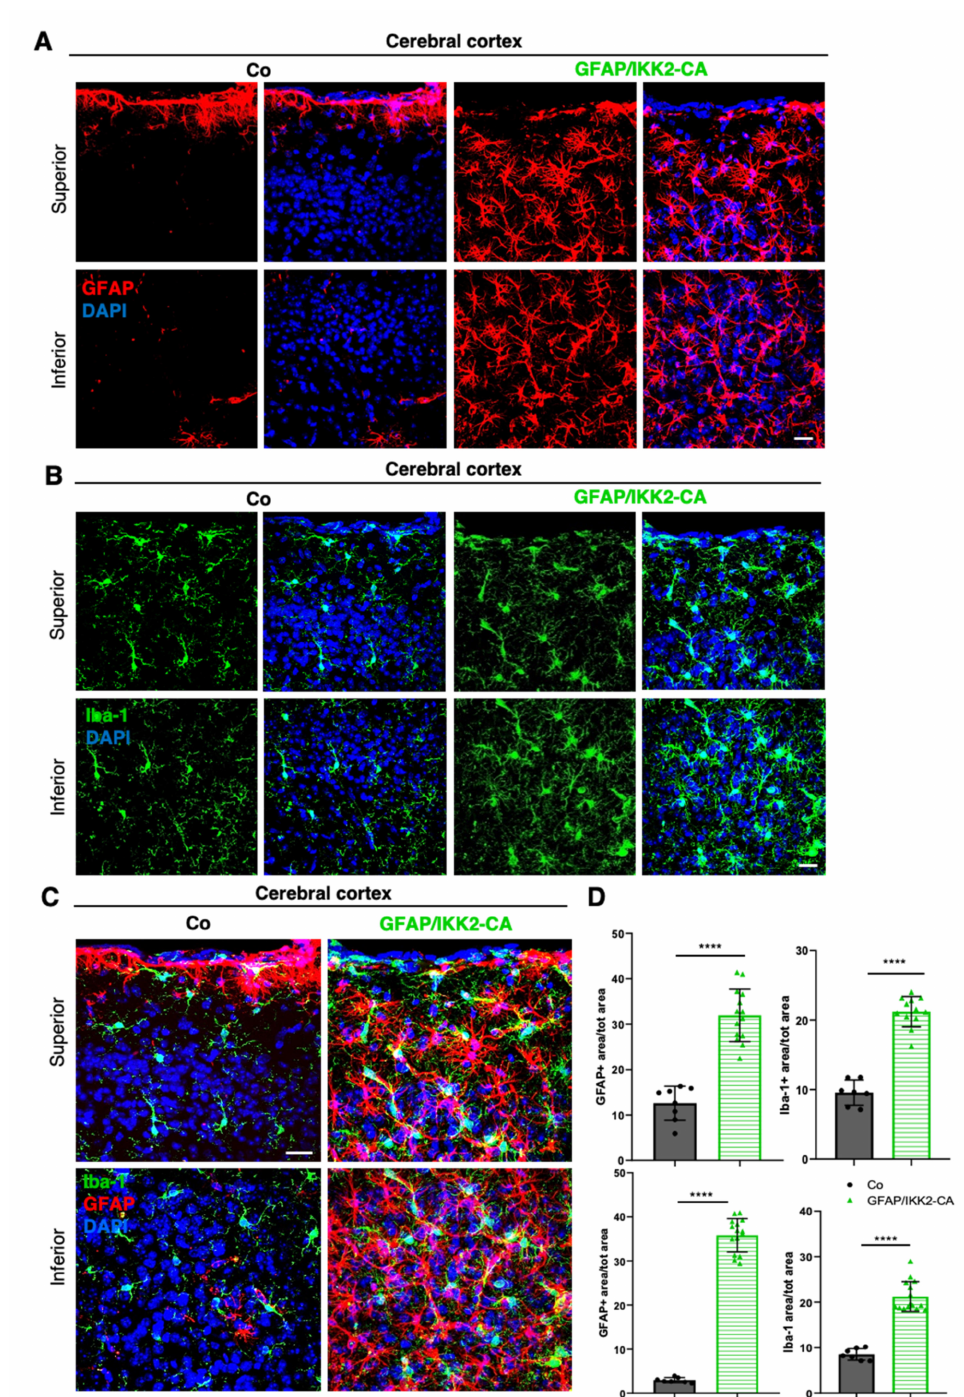
Figure 2. Selective activation of IKK2/NF- κ B signaling in astrocytes induces strong astrogliosis and microgliosis. Representative pictures showing IF staining of astrocytic marker GFAP ( A ) and microglial cells marker IBA-1 ( B ) in the superior and inferior cerebral cortex of control mice and GFAP/IKK-CA littermates. ( C ) High-magnified pictures depicting co-IF staining of GFAP and IBA-1 markers in the superior cerebral cortex. The panel displays interaction between the two types of glial cells and underlines the increase in number and area covered by astrocytic and microglial cells in GFAP/IKK2-CA mice in relation to Co littermates. Nuclei are labeled with DAPI (blue). ( D ) Quantitative analyses show a significant increase in GFAP+ astroglia ( A ) and IBA-1+ microglia area ( B ) in the GFAP/IKK2-CA mice compared to control mice. Cryo-sections thickness = 40 µ m; Scale bar = 20 µ m. Statistical analysis: ANOVA multiple comparison test (**** p =